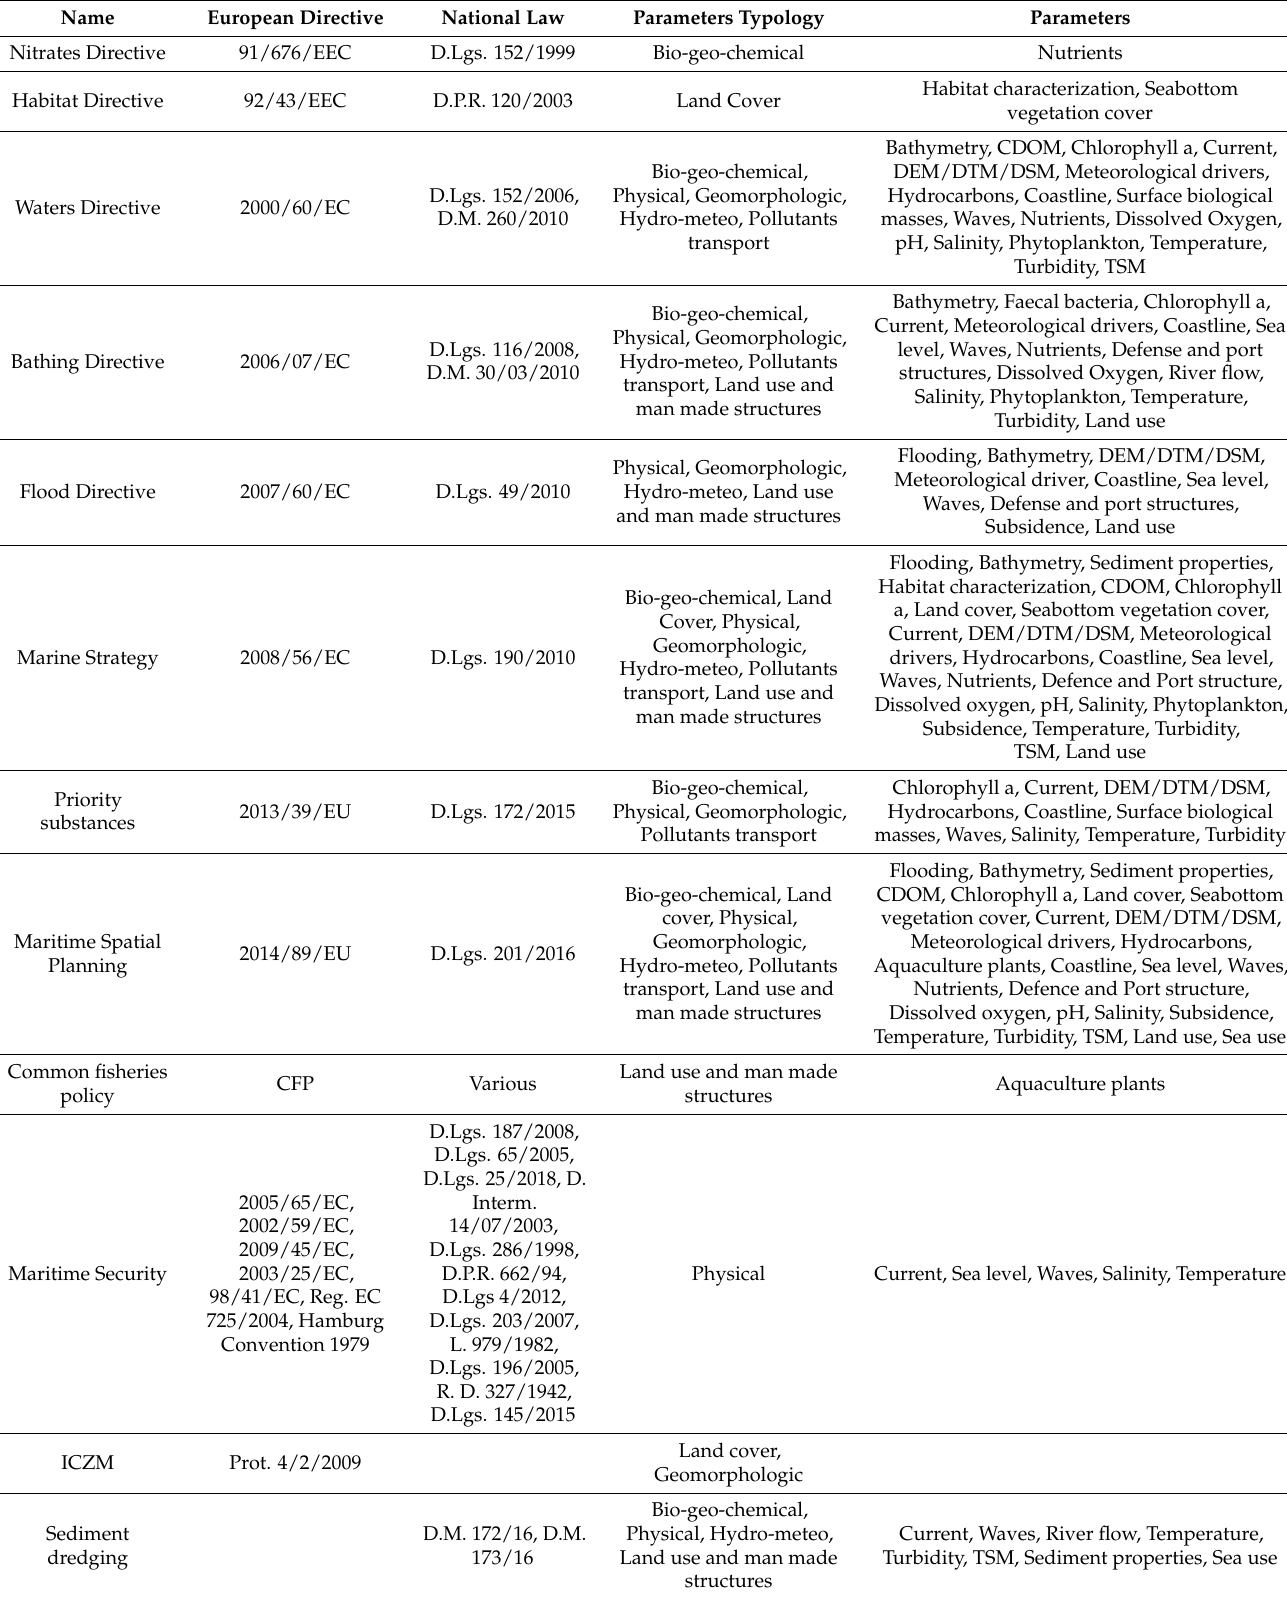
Table 2. Link between the parameters required by institutional users and the reference